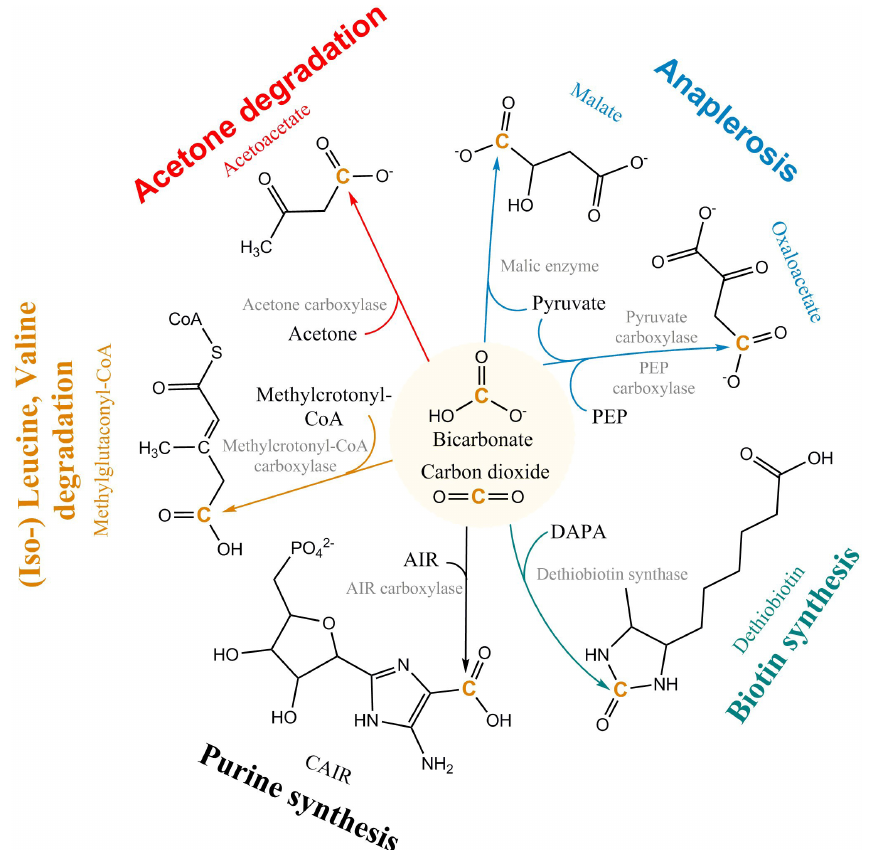
Figure 1. Selected heterotrophic CO 2 fixation reactions and pathways. PEP: phosphoenolpyruvate; DAPA: 7,8-diaminononanoate; AIR: 1-(5 (cid:48) -phosphoribosyl)-5-aminoimidazole; CAIR: 1-(5-phospho-D-ribosyl)-5-amino-4-imidazolecarboxylate; CoA: